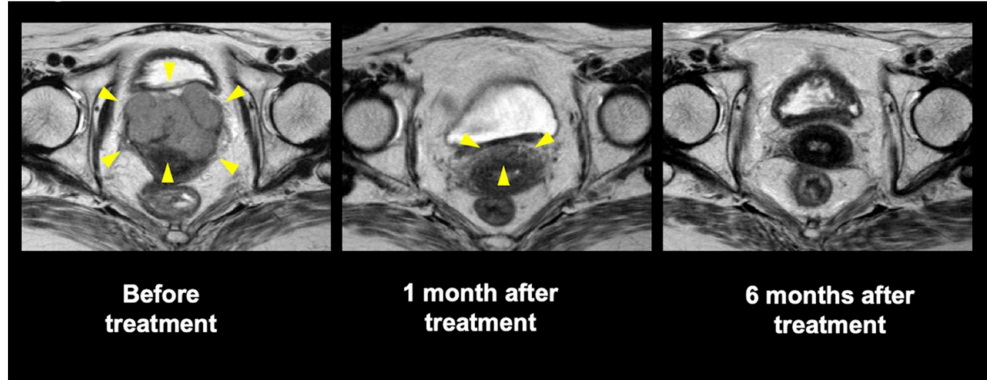
Figure 3. Pelvic magnetic resonance imaging of a representative patient who underwent carbon-ion radiotherapy. Yellow arrow: tumor or remained